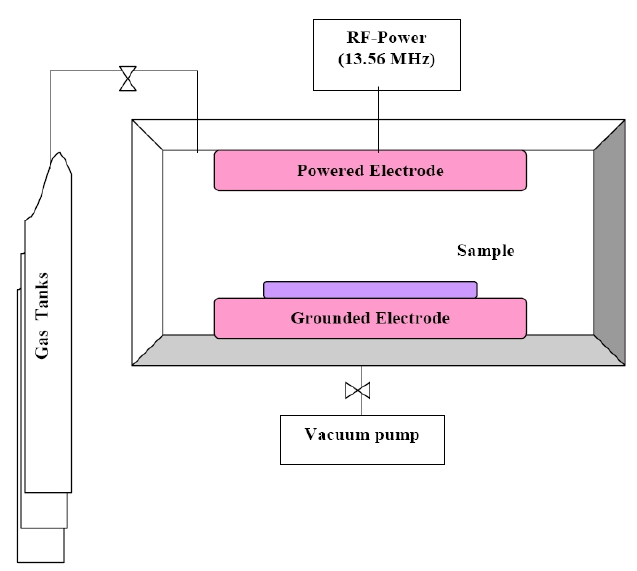
Fig. 1 Capacitively coupled parallel plate static RF- cold plasma reactor.